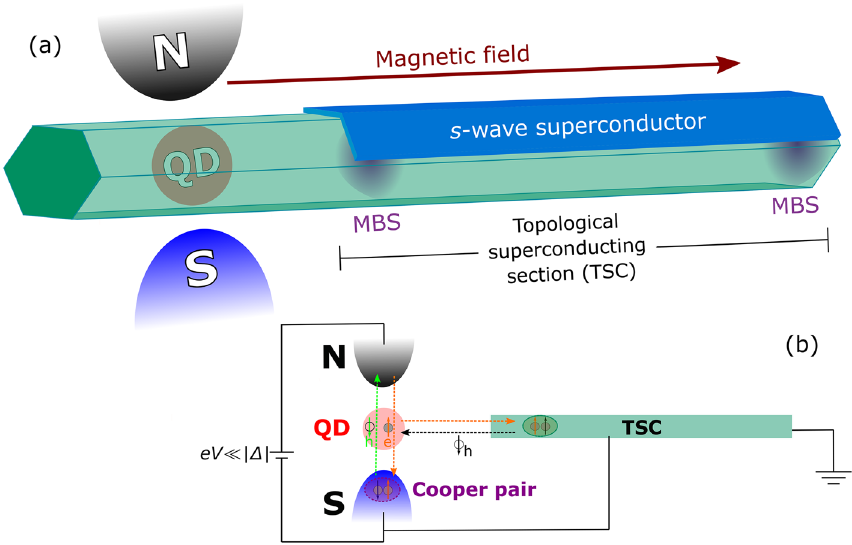
Figure 1. ( a ) Sketch of the considered setup. It consists of a QD working as a local probe coupled to normal (N) and superconducting (S) leads and a segment of a semiconductor nanowire covered by an s -wave superconductor layer. In the presence of an external magnetic field parallel to the wire, the latter is driven into a topological superconducting state, with Majoranas bound states (MBSs) formed at its opposite ends. ( b ) The scheme illustrating spin-dependent transport channels in the system. Finite bias voltage eV is applied between superconducting (S) and normal (N) reservoirs. An incoming electron from the normal reservoir with a certain spin is injected into the QD and is reflected back as a hole. In the same time, a Cooper pair is formed either in the superconducting reservoir, where it has ordinary s -wave character, or in the TSC, where it has a p -wave symmetry. The interplay between the transport through S and TSC terminals defines the spin orientation of the reflected hole with respect to the spin of the incoming